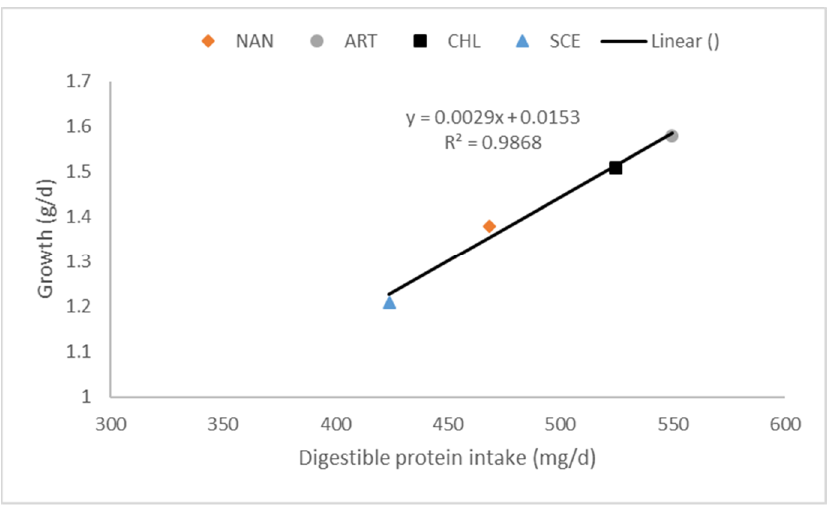
Figure 2. Relationship between digestible protein intake and growth rate in Nile tilapia fed diets containing 30% of each of various microalgal SCP resources (calculated from data published by Teuling et al., [102]) (NAN = Nannochloropsis gaditana ; ART = Arthrospira maxima ; CHL = Chlorella vulgaris ; SCE = Scenedesmus dimorphus ).